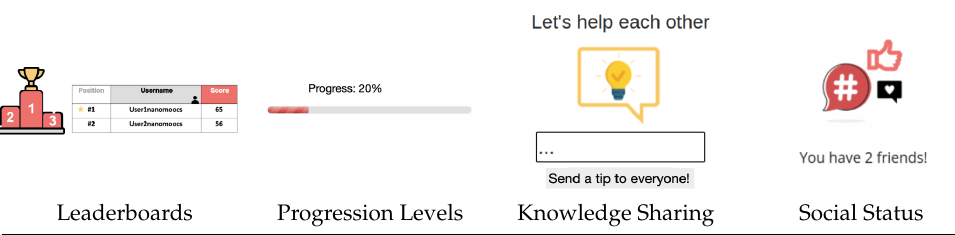
Table 3. Game Elements that shows the student’s status in the learning process and in the